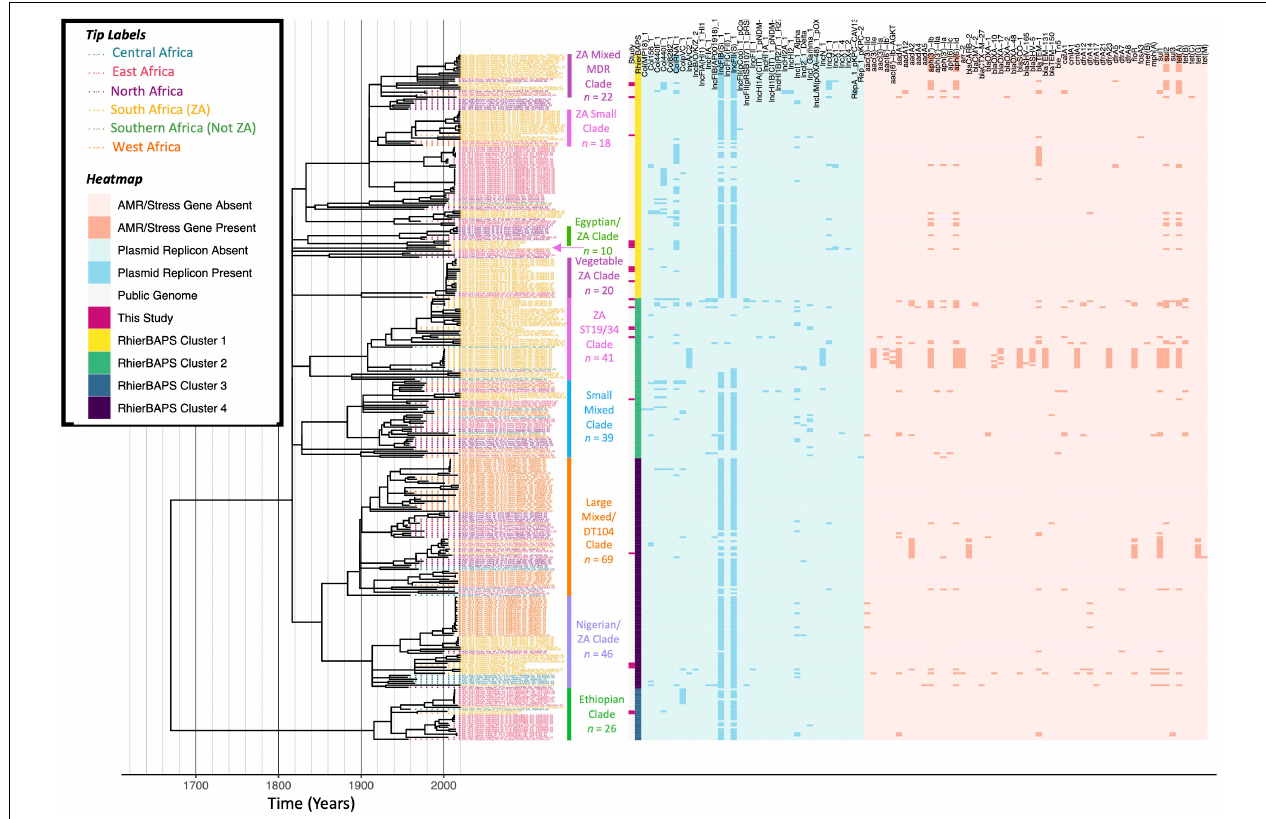
FIGURE 7 | Maximum likelihood phylogeny constructed using core SNPs identified among 343 African S. Typhimurium genomes (319 publicly available genomes, plus the 24 sequenced here). Tip label colors denote the region/country from which each strain was reported to have been isolated (based on African regions as defined by the African Union, 25 April 2021). Clade labels denote clades discussed in either the main manuscript or the Supplementary Text . The heatmap to the right of the phylogeny denotes: (i) whether an isolate was sequenced in conjunction with this study (dark pink) or not (gray; “Study”); (ii) level 1 cluster assignments obtained using RhierBAPS (“RhierBAPS”); the presence and absence of (iii) plasmid replicons (blue) and (iv) antimicrobial resistance (AMR) determinants (orange). The phylogeny was rooted and time-scaled using LSD2, with branch lengths reported in years ( X -axis). Core SNPs were identified among all genomes using Parsnp. AMR determinants were identified using ABRicate, the NCBI AMR determinant database, and minimum identity and coverage thresholds of 75 and 50%, respectively. Plasmid replicons were identified using ABRicate and the PlasmidFinder database, using minimum identity and coverage thresholds of 80 and 60%, respectively. The phylogeny was constructed and annotated using IQ-TREE and bactaxR/ggtree,